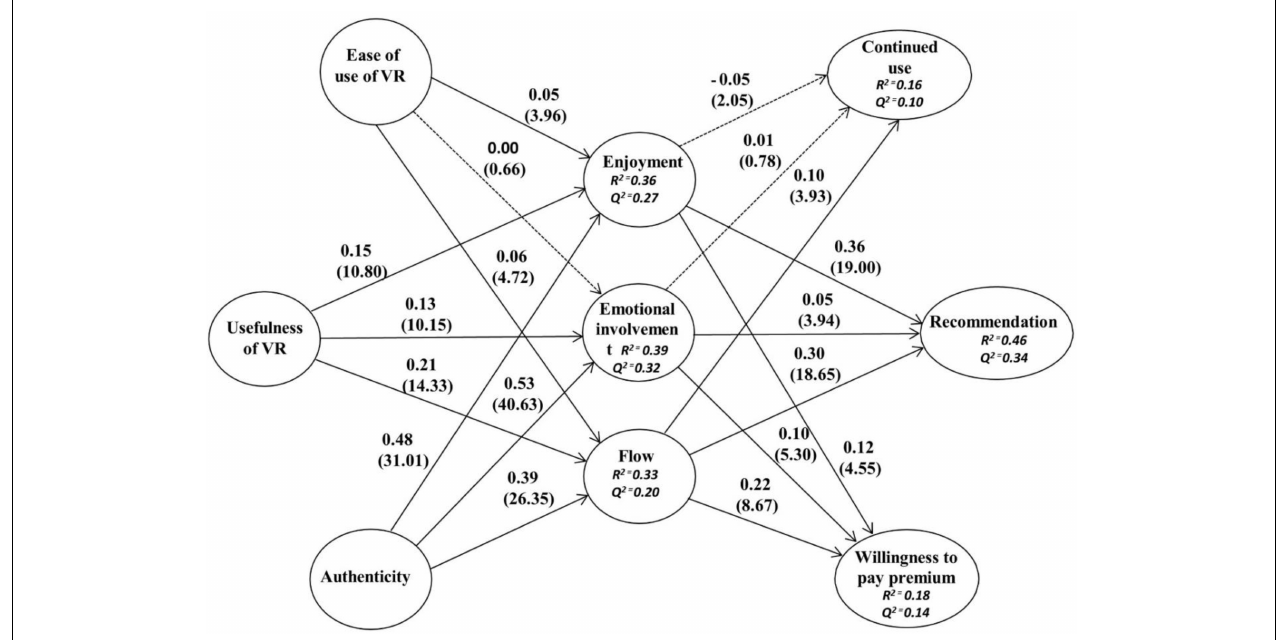
FIGURE 2 | Results of path analysis main effects. The dotted arrow shows the non-significant path coefficient, and t -values are presented in parentheses.